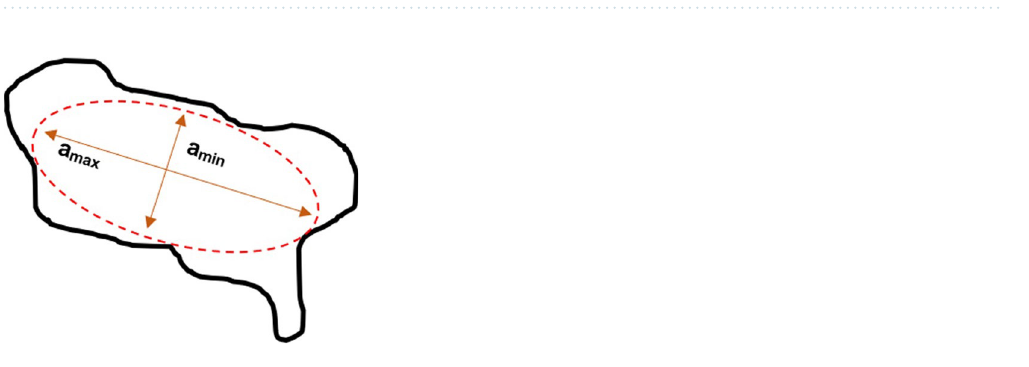
Figure 4. Microtomography equipment from the DEN laboratory. ( a ) View inside the equipment and ( b ) View of the software.